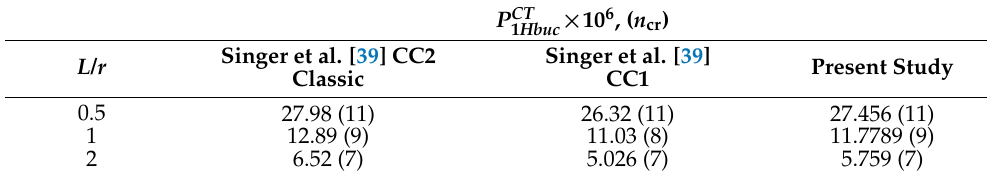
Table 1. Comparison of P CT for single-layer isotropic cylindrical shells with clamped edges. 1 Hbuc